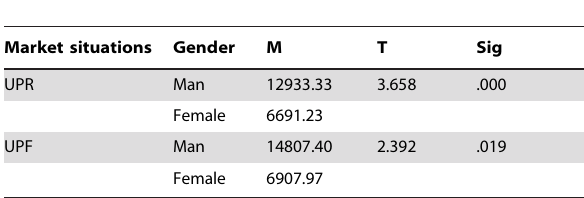
Table 4. T-test of the effect of gender on trading